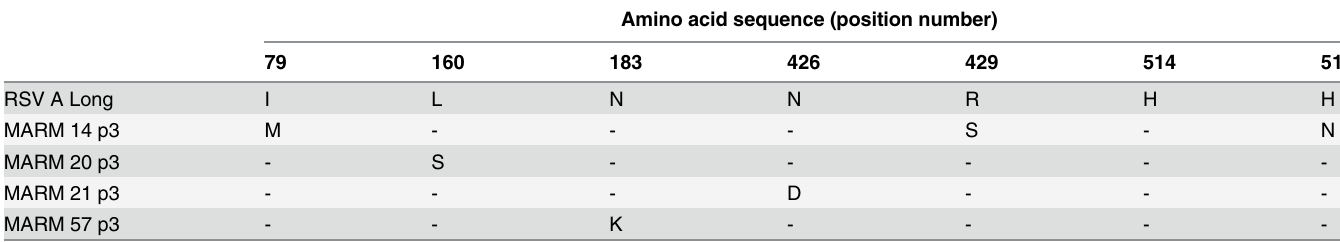
Table 1. Amino acid changes in F protein of AM14 MARMs.